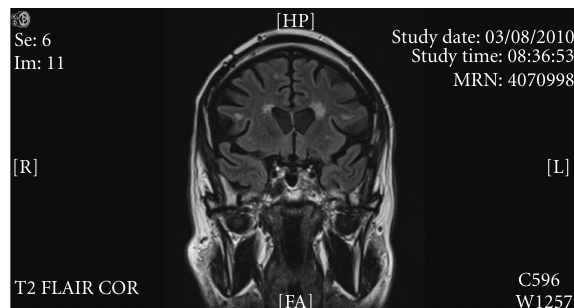
Figure 1: Periventricular and subcortical white matter hyperinten- sities. MRI, T2-weighted sequence,